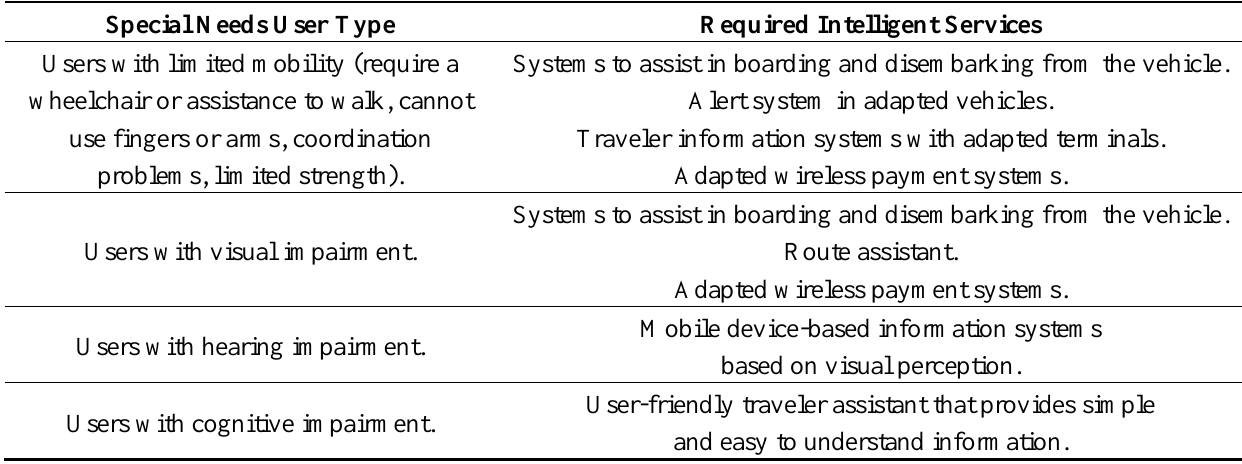
Table 1. Special needs user groups and required system